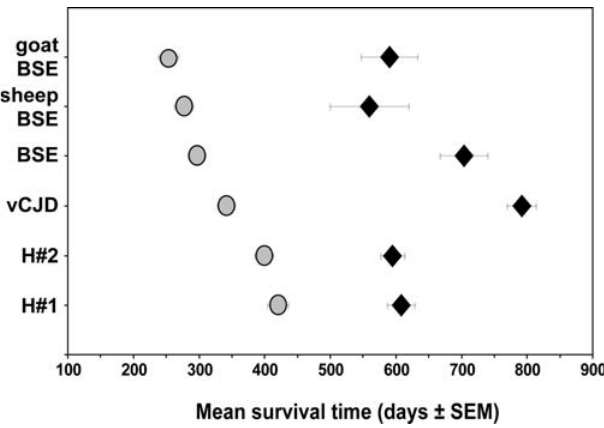
Figure 1. Survival Time in Transgenic Mice Infected with H-Type and BSE-Type Agents Mean survival times (days 6 SEM) upon primary transmission are shown for tgBov (grey circles) and tgOv (black diamonds) mice inoculated with H-type cases, BSE, and related isolates (see Table 1). The intervals between the incubation times on each line are significantly different for H-type and BSE agents ( p , 0.0002, Fisher test). DOI: 10.1371/journal.ppat.0020112.g001